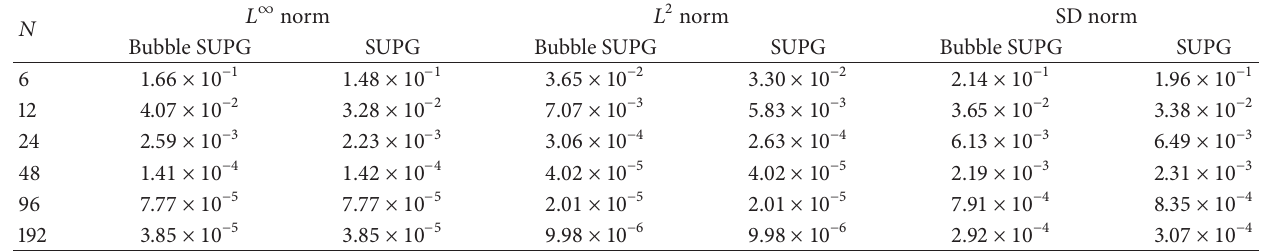
Table 12: 𝜀 = 10 −2 , Problem 3 (comparison of convergence